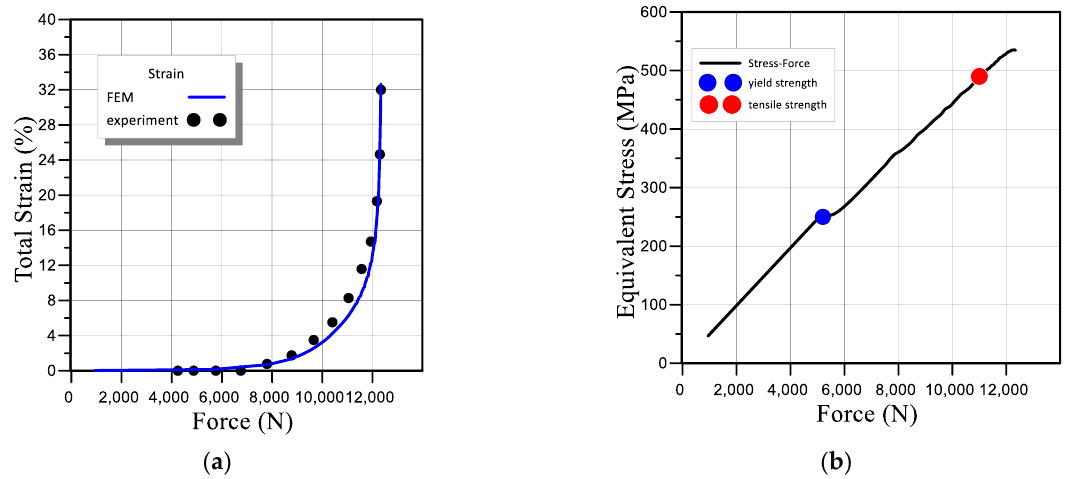
Figure 6. Comparison of calculated values of strain ( a ) and stress ( b ) using experimental data.